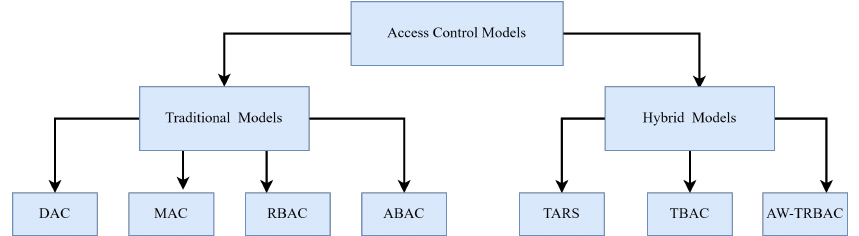
Figure 5. Classification of access control mechanisms currently being adopted in cross-domain